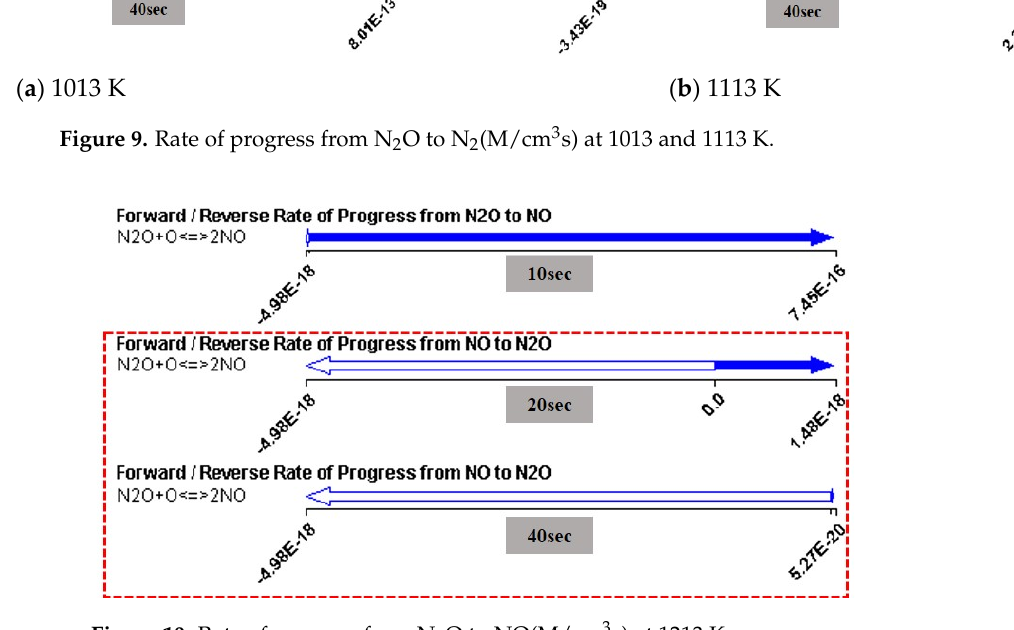
Figure 10. Rate of progress from N 2 O to NO(M/cm 3 s) at 1213 K. Table 6. Rate of progress between N 2 O and